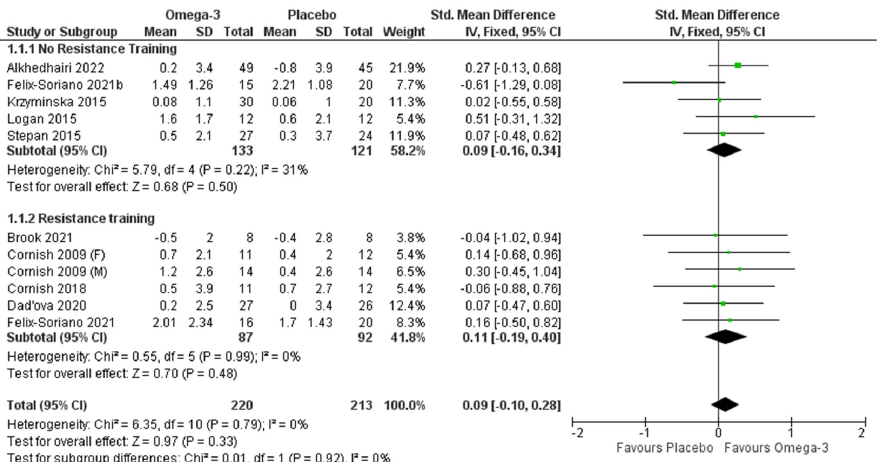
Figure 2. Pooled analysis of the impact of omega-3 supplementation on lean body mass with and without resistance training [27,29,31,34,35,37,39,40].